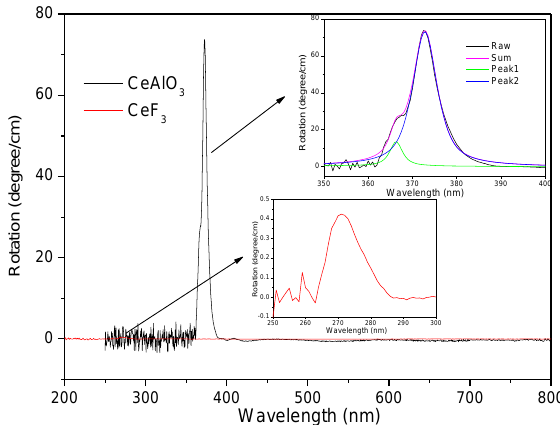
Figure 10. Magnetic circular dichroism (MCD) spectra of CeAlO 3 and CeF 3 crystals, Inset: Peak position of CeAlO 3 and CeF 3 crystals.